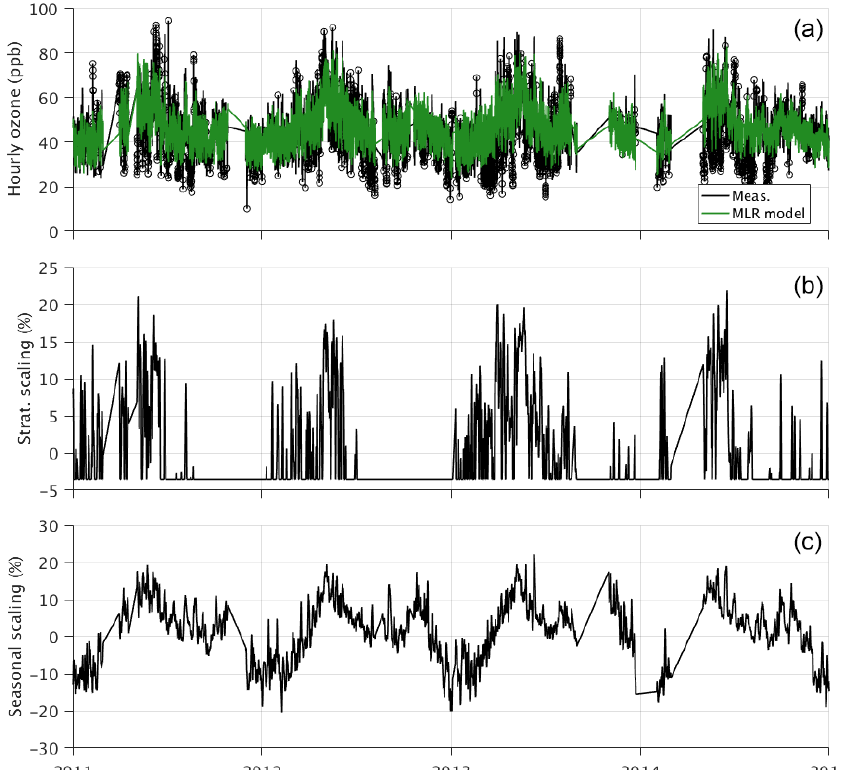
Figure 4. (a) Surface hourly measurements of ozone at Nam Co (black) and multi-linear regression (MLR) model fit (green). Outliers rejected by the iteratively re-weighted least-squares procedure are shown as circles. (b) Impact of the CAMx stratospheric tracer on surface ozone concentration in the regression model expressed as a percentage change relative to the model average. (c) Impact of the seasonal factor (Eq. 2) on surface ozone